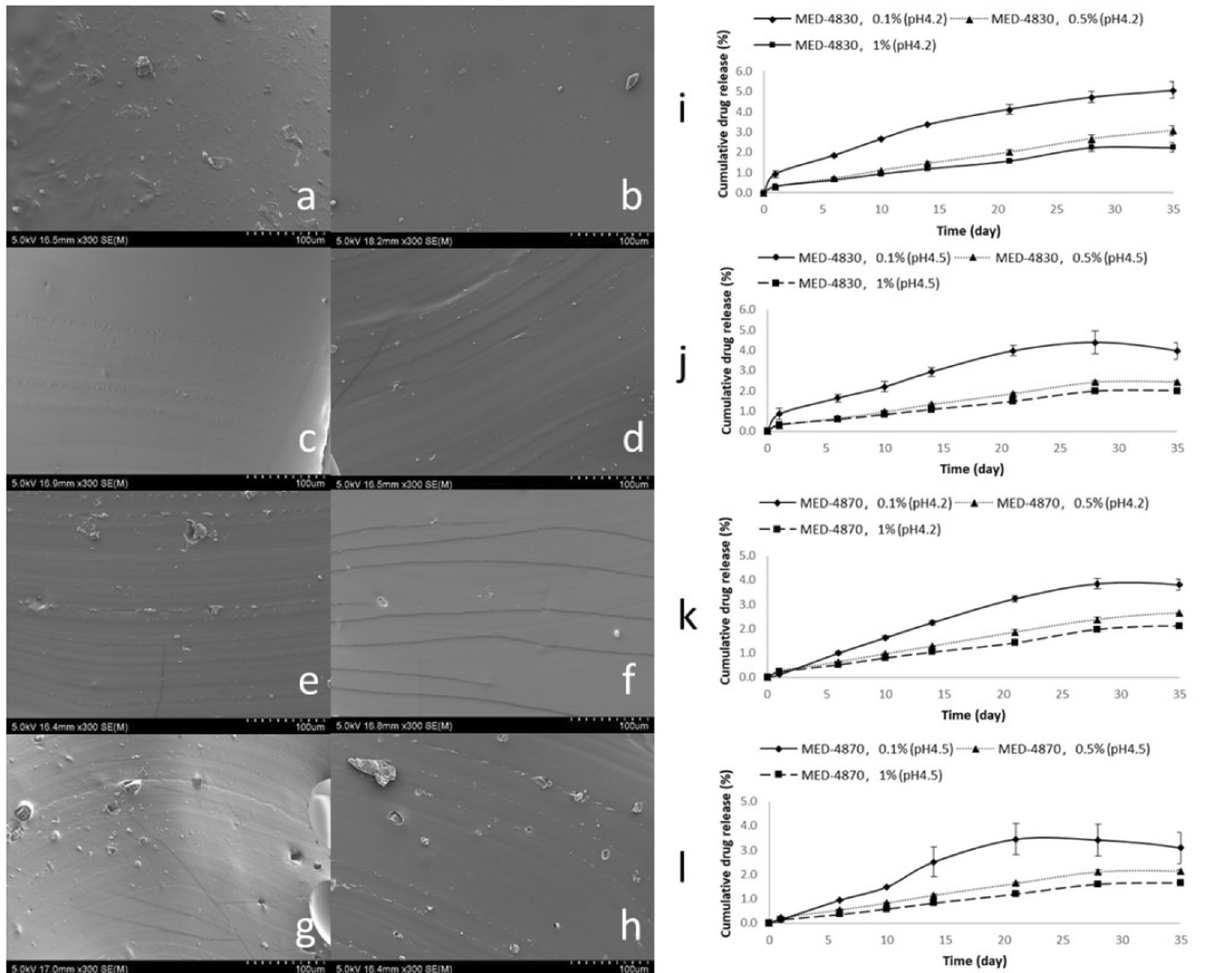
Figure 1. Scanning electron microscope cross section micrographs of MED-4830 and MED-4870 films( a–h ): ( a ) MED-4830, drug-free sample; ( b ) MED-4870, drug-free sample; ( c ) MED-4830, 0.1% drug content; ( d ) MED-4870, 0.1% drug content; ( e ) MED-4830, 0.5% drug content; ( f ) MED-4870, 0.5% drug content; ( g ) MED- 4830, 1% drug content; and ( h ) MED-4870, 1% drug content. In vitro release of estriol from silicone films based on different silicone materials, drug contents and release conditions ( i–l ): ( i ) MED-4830 silicone films released in simulated vaginal fluid (SVF) of pH 4.2; ( j ) MED-4830 silicone films released in SVF of pH 4.5; ( k ) MED- 4870 silicone films released in SVF of pH 4.2; and ( l ) MED-4870 silicone films released in SVF of pH 4.5; solid line represents 0.1% drug content, dotted line represents 0.5% drug content and dashed line represents 1% drug